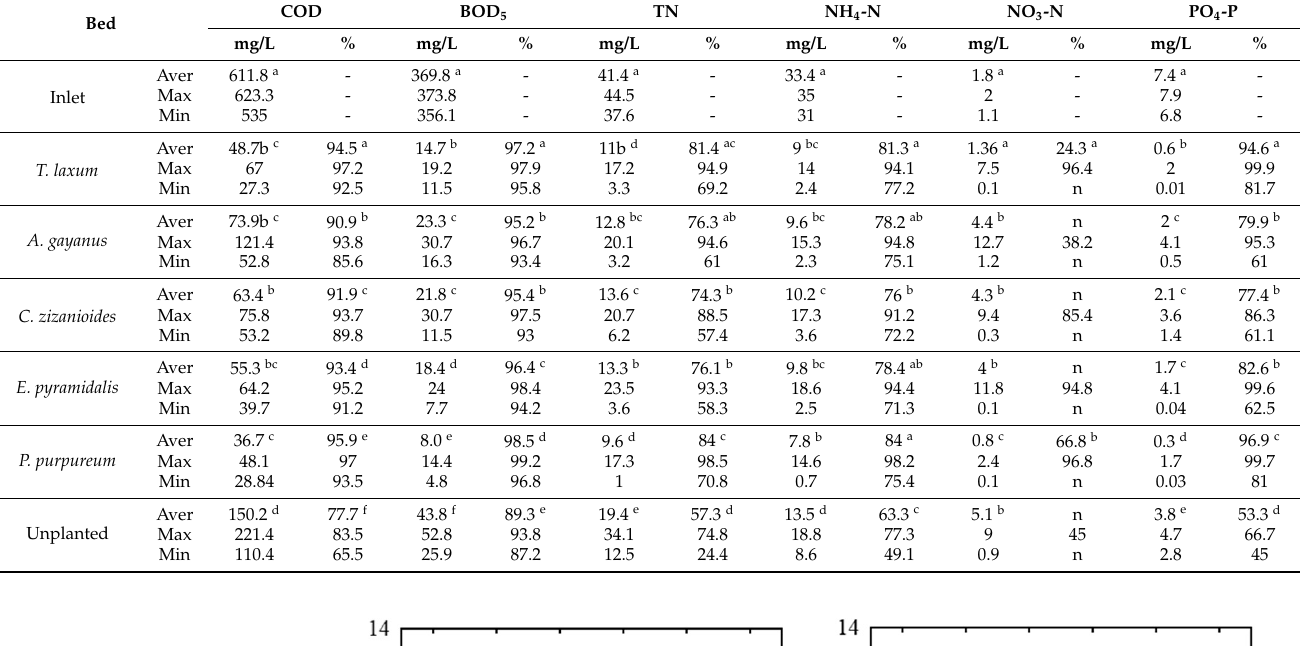
Table 4. Average (aver), maximum (max), and minimum (min) concentrations (mg/L) and removals (%) of different parameters in the inlet and the outlet of the pilot VFCWs with different plant species. Values within the same column followed by the same superscript letter (i.e., a, b, c, d, e, f) are not statistically significantly different at p < 0.05.